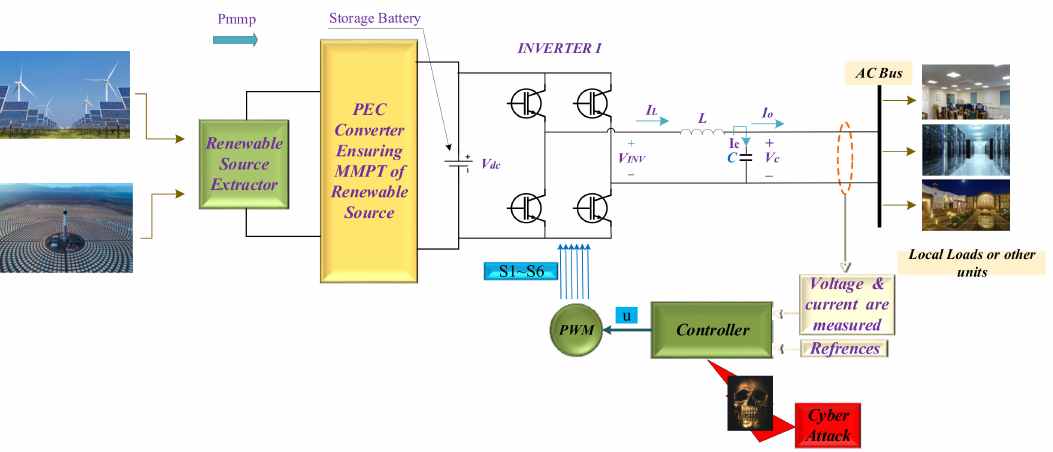
Figure 3. Typical layout of a single-phase distributed generation unit in front of a